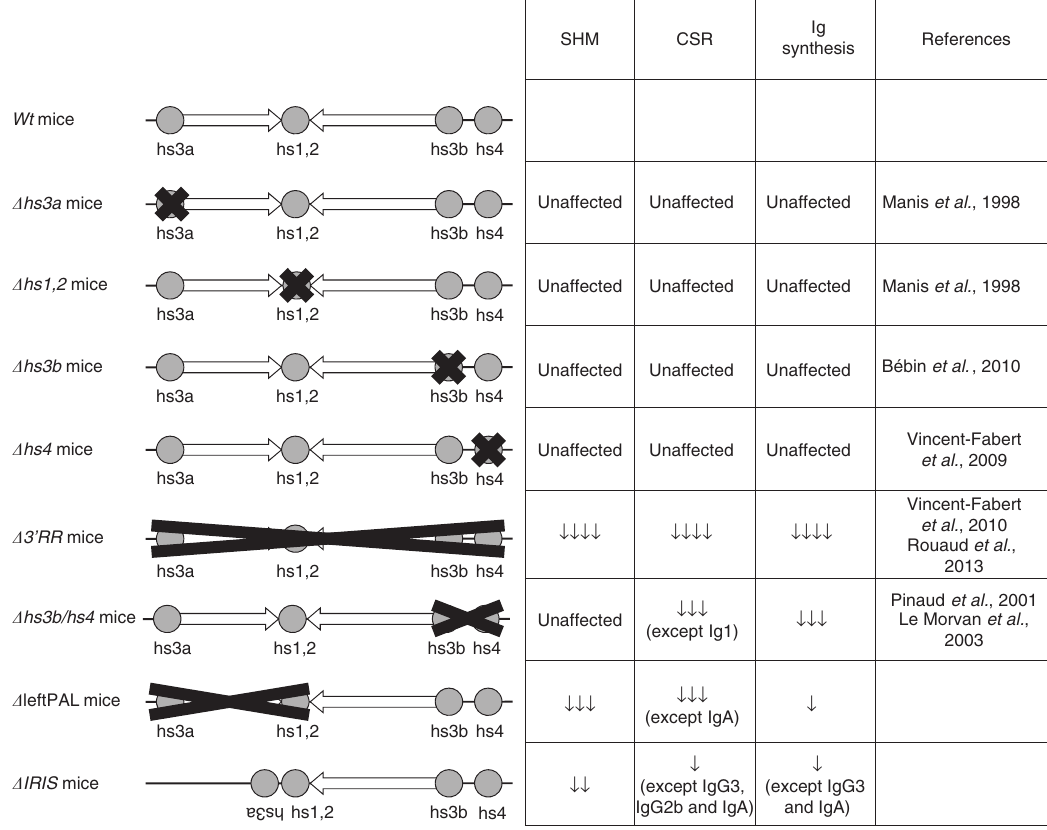
Figure 8 | Mutants of the 3’RR enhancers. References and main results are reported and compared with D leftPAL and D IRIS mice. NATURE COMMUNICATIONS|7:10730|DOI: